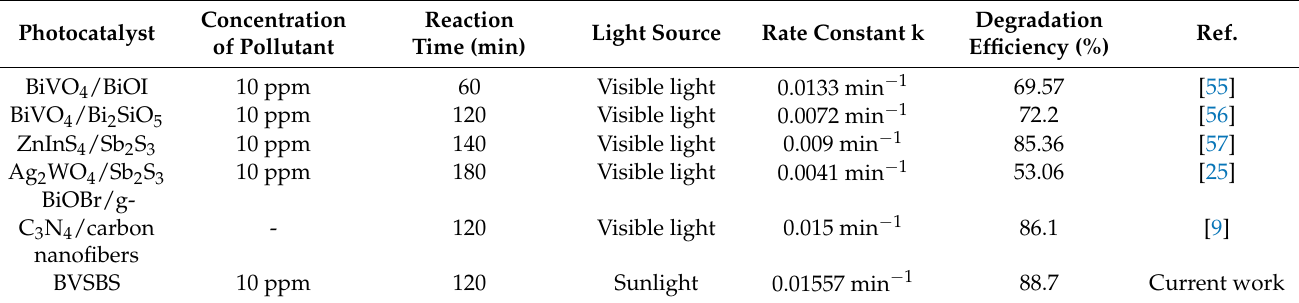
Table 3. Comparison of the different photocatalysts for the photocatalytic abatement of the colorless pollutant,